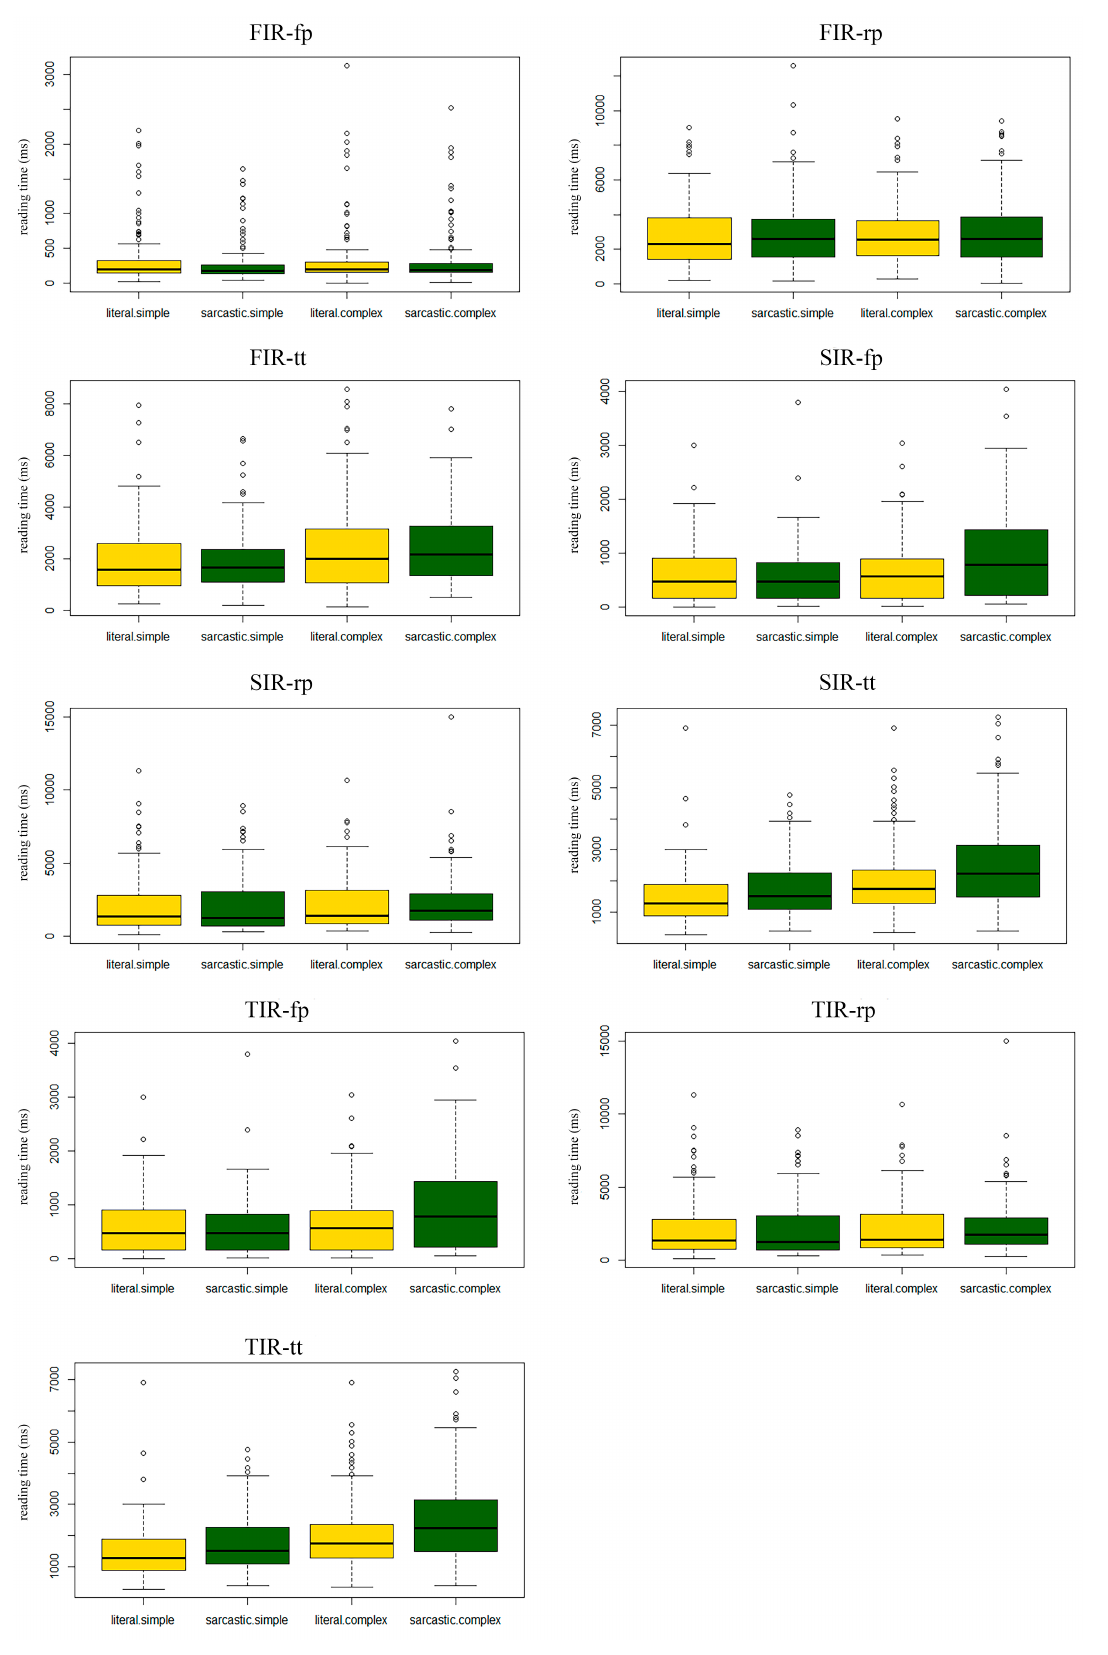
Figure 1. Reading times for the three regions of interest as a function of the type of sentence (literal, sarcastic) and level of complexity (simple, complex).